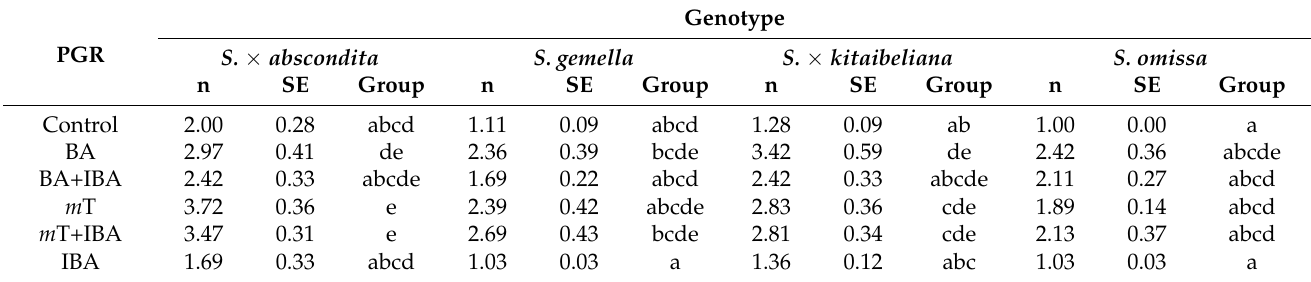
Table 1. The effect of interaction between the genotype and the PGR treatment on the mean number of shoots per explant in Sorbus species (n). The term SE denotes corresponding standard error; group shows significant differences according to Tukey’s range test ( p -value =